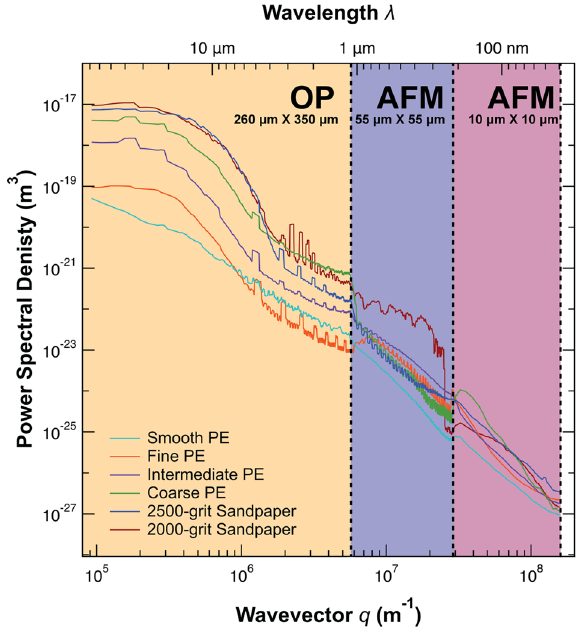
Figure 3. One dimensional surface roughness power spectral density (PSD) functions for each experimental substrate as a function of wavelength (λ) and wavevector q = 2π/λ. The PSDs illuminate qualities of the surfaces that were otherwise unknown via comparisons of RMS height. Regions of the figure with different fill colours indicate the primary range of wavelengths measured by each technique (OP = optical profilometry; AFM = atomic force microscopy). Note that the dashed vertical lines are not hard cut-offs; the data from each technique and/or scan size overlaps with at least one other technique and/or scan size, yet most data from each technique/scan size lies within the indicated